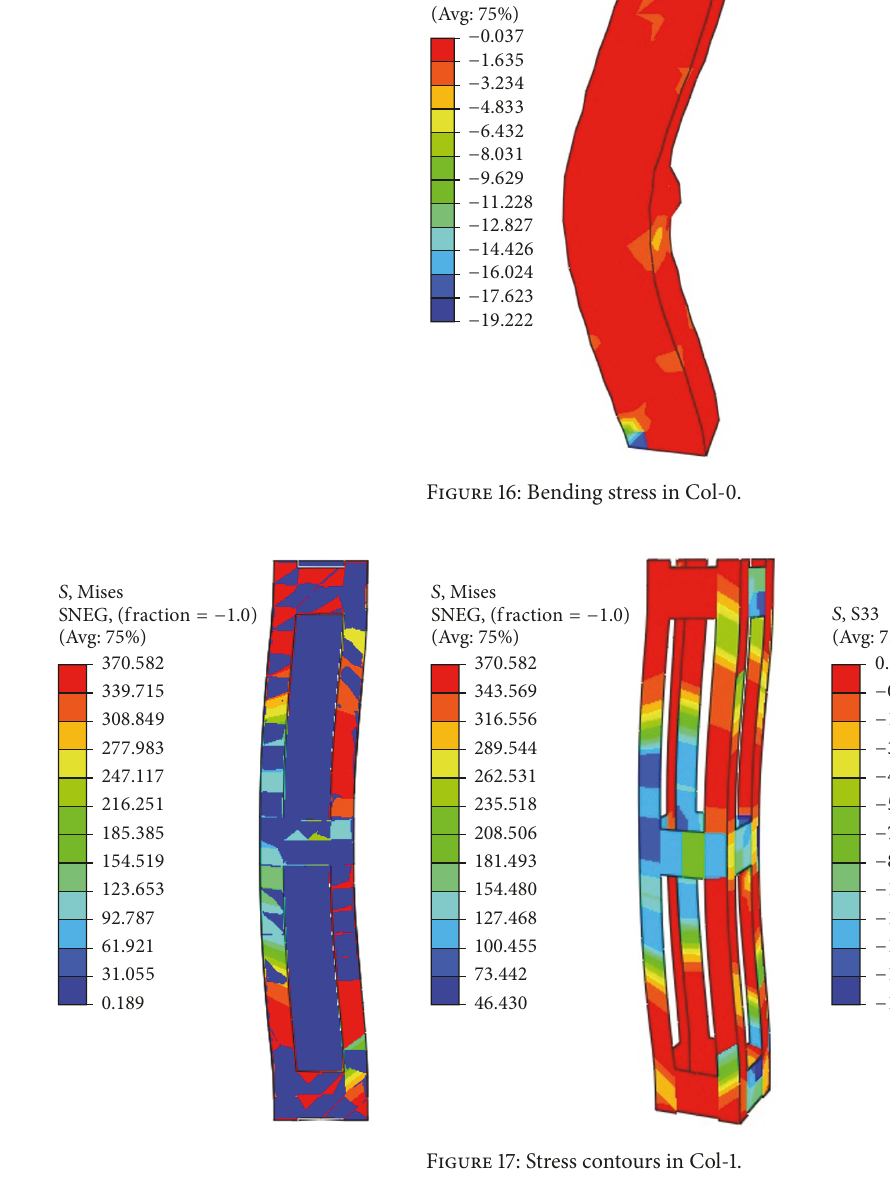
Figure 17: Stress contours in